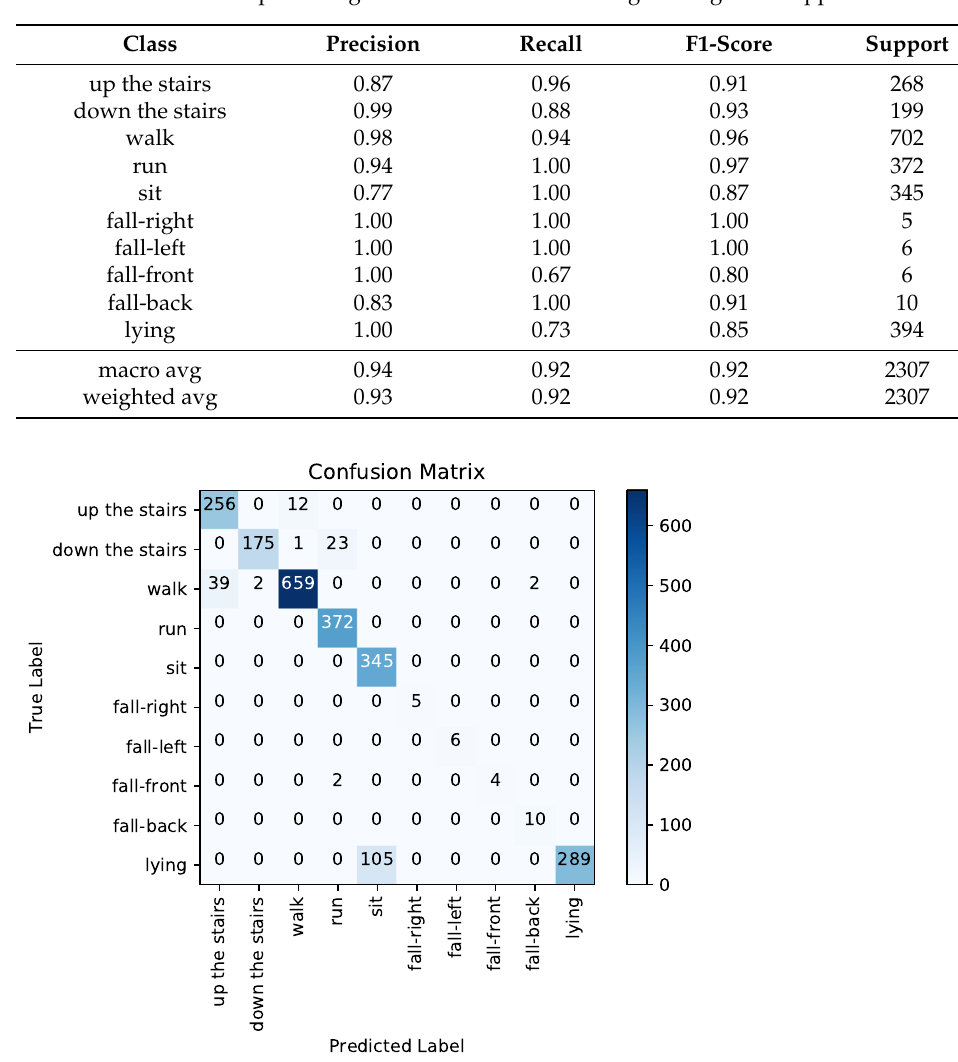
Table 1. Classification report using the handcrafted feature engineering-based approach.